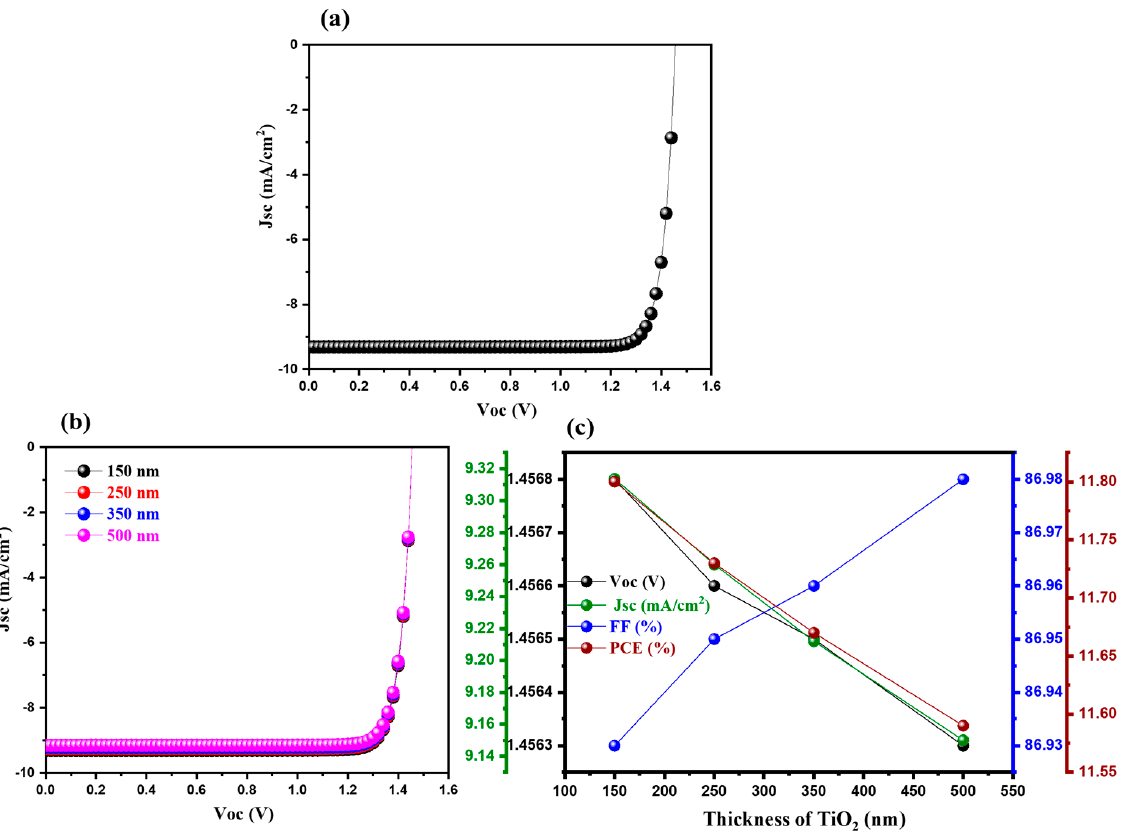
Figure 1. J–V response ( a ) of FTO/TiO 2 (150 nm)/MA 3 Sb 2 I 9 (250 nm)/spiro-OMeTAD(350 nm). J–V response ( b ) and corresponding photovoltaic parameters ( c ) of FTO/TiO 2 (150–500 nm)/MA 3 Sb 2 I 9 (250 nm)/spiro-OMeTAD(350